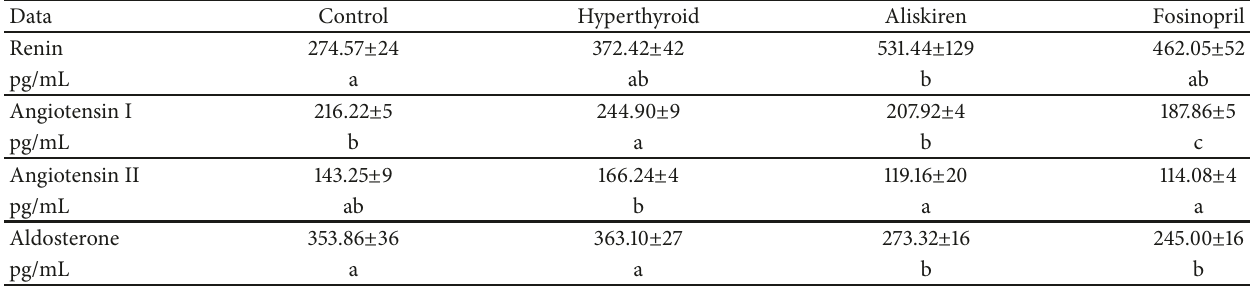
Table 2: Effects of hyperthyroidism, Aliskiren, and Fosinopril on serum levels of renin, angiotensin I & II, and aldosterone. Data Control Renin pg/mL a ab b ab Angiotensin I pg/mL b Angiotensin II pg/mL ab b Aldosterone pg/mL a a b b Different letters indicate significance differences at P <